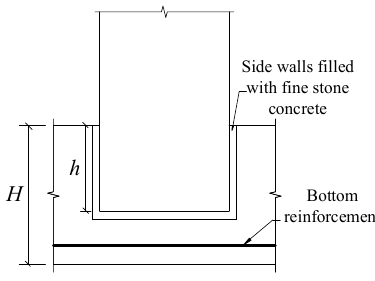
Figure 1. Traditional socket